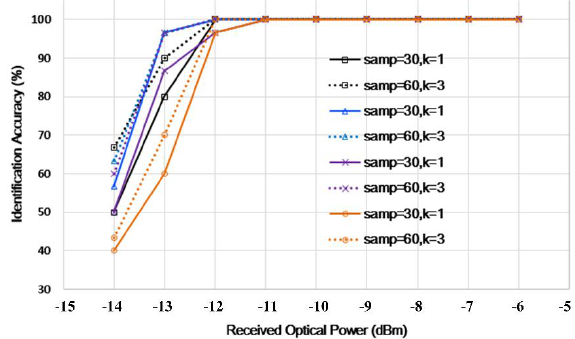
Figure 4. ( a ) The constellations, ( b ) AH (RoP = − 11 dBm and − 6 dBm) of mixed QAM modulation format from 4-QAM to 128-QAM.